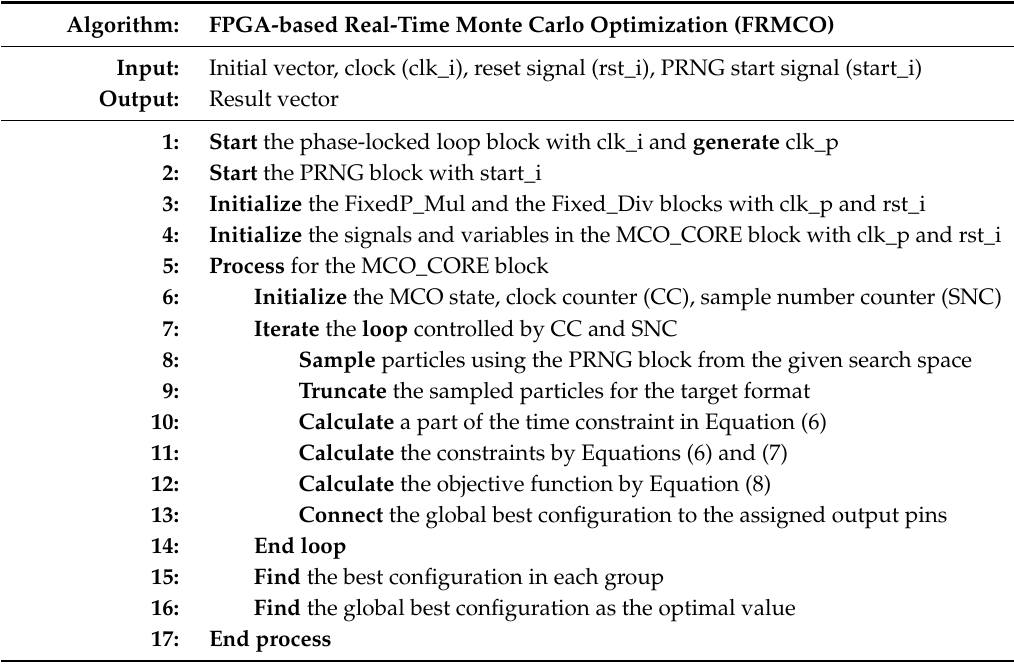
Figure 5. The FPGA structure of the FRMCO which is the proposed method on FPGA. Algorithm 1. The pseudo-code of the core algorithm of the